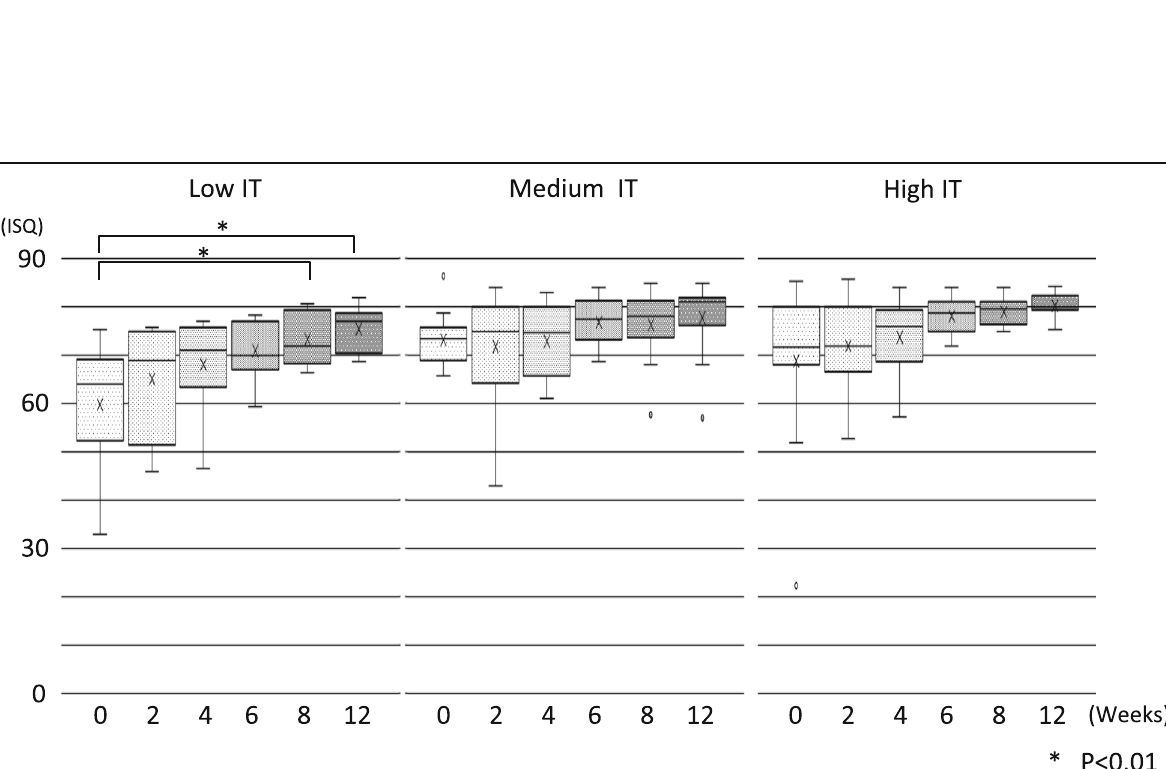
Fig. 5 The comparison of ISQ values by the insertion torque. Time-lapse migration of ISQ values was compared with IT groups. Each IT group displayed similar migration. A significant difference in The ISQ was found in the low IT group after 8